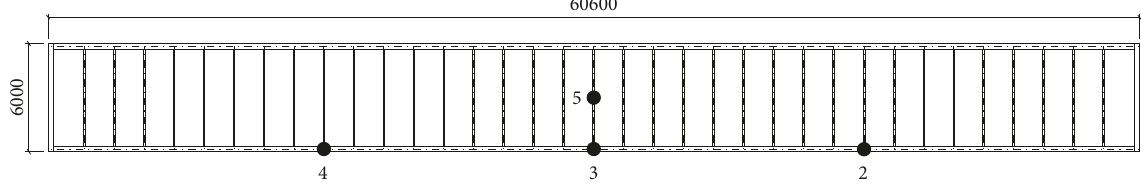
Figure 9: 60m aerial corridor structure vibration test point layout (top view).